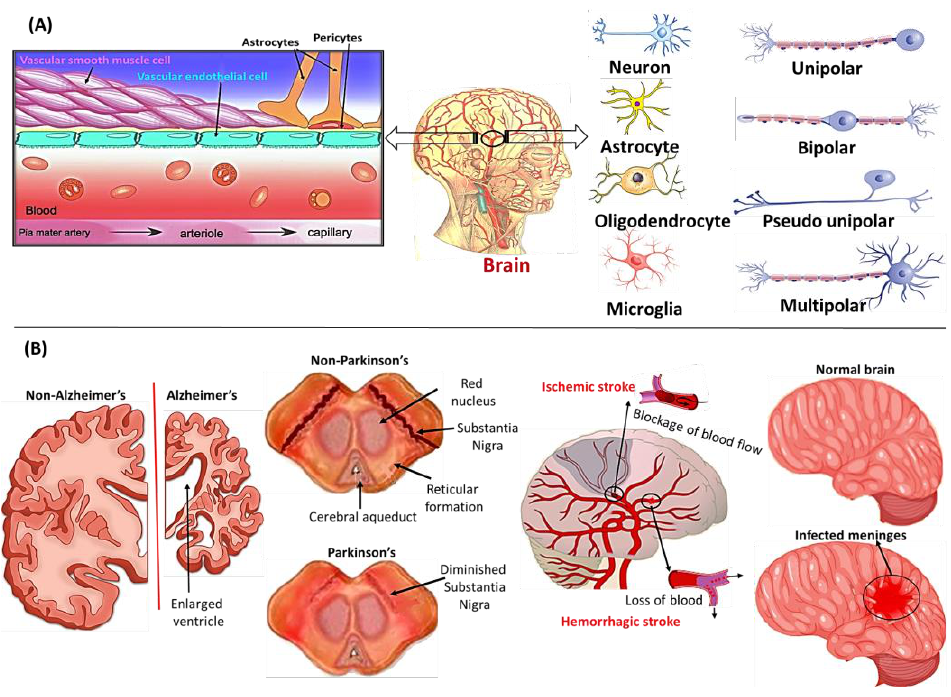
Figure 1. ( A ) A three-dimensional view of the BBB anatomy, composed of vascular endothelial cells, vascular smooth machine cells, pericytes, microglia cells, astrocytes, and various neurons (Source: https://commons.wikimedia.org/wiki/File:Blood_vessels_brain_english.jpg); ( B ) the appearance of different neurodegenerative diseases, such as AD, and PD, ischemic and hemorrhagic stroke, and meningitis-associated damage due to the dysfunction of the BBB. This published work is licensed under a Creative Commons Attribution 3.0. Table 1. List of the therapeutic drugs used in the treatment of NDs and their modes of action. NDs